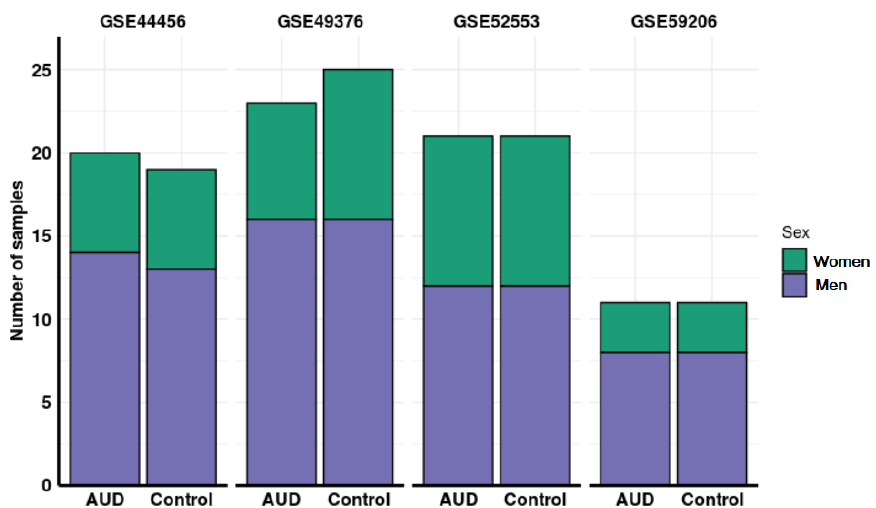
Figure 3. Distribution of samples by sex and addiction status in each of the studies analyzed.